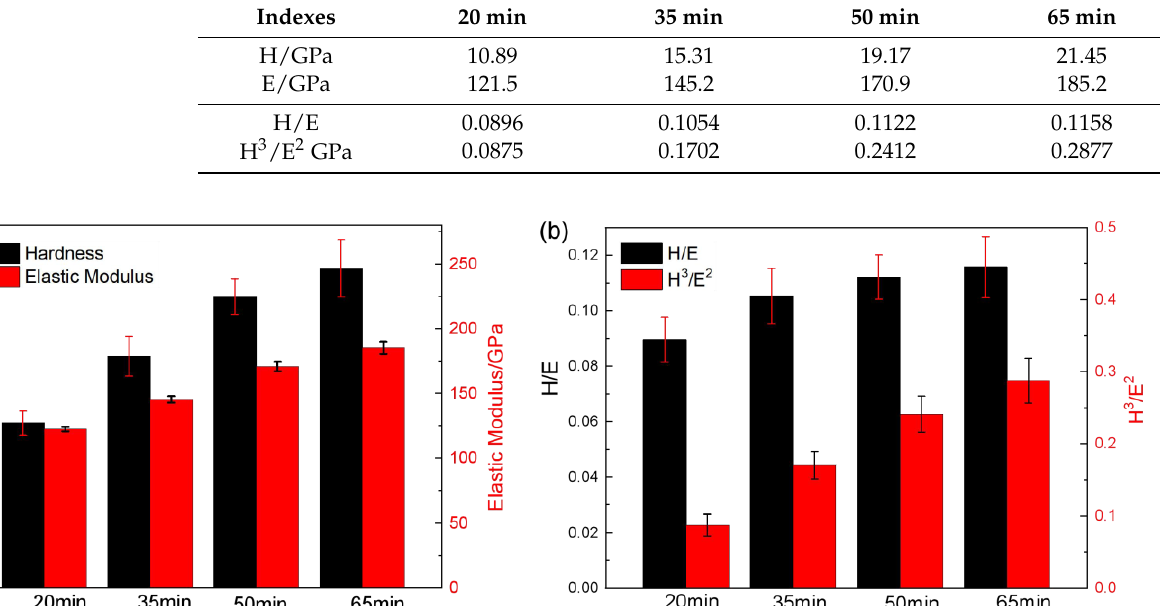
Figure 3. Mechanical property index of the Nano-indentation test. ( a ) H and E; ( b ) Elasticity factor (H/E) and shaping factor (H 3 /E 2 ).